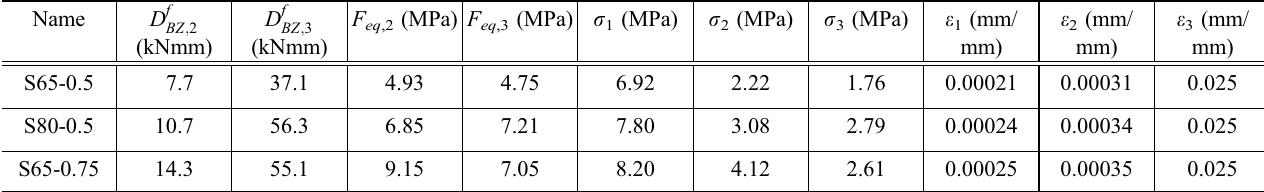
Table 7 Parameters for modeling tensile stress block of